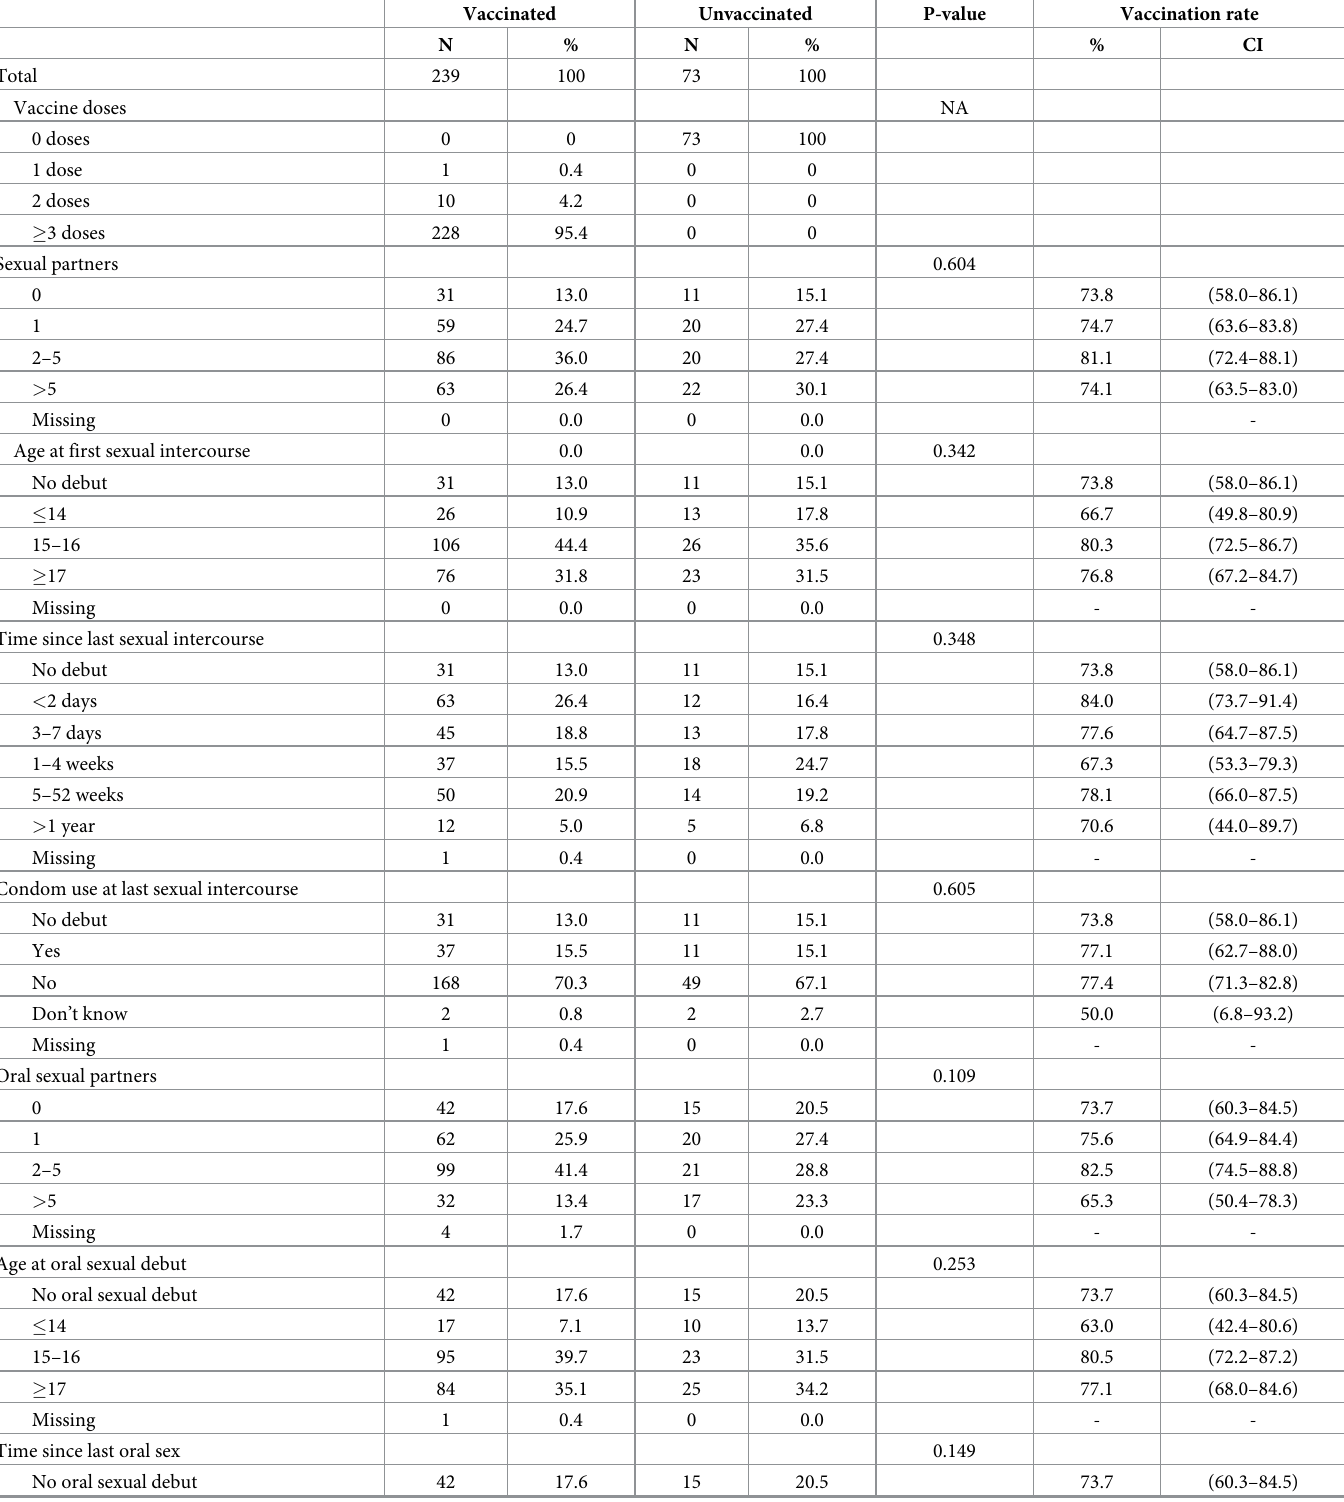
Table 1. Baseline characteristics and questionnaire-reported sexual behavior by human papillomavirus vaccination status. Vaccinated